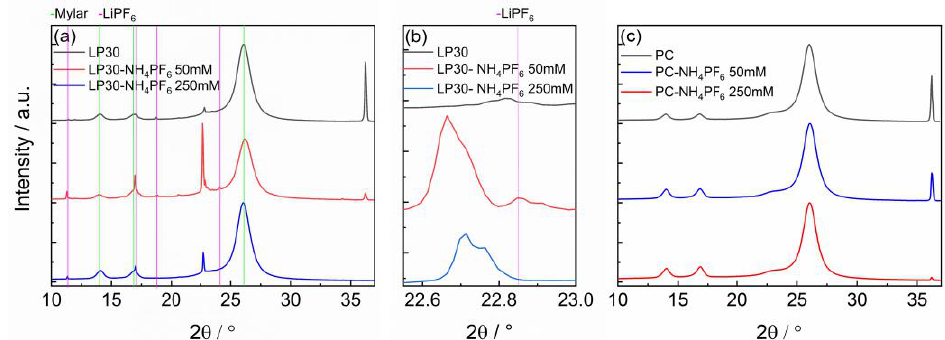
Figure 10. X-ray diffraction patterns of lithium samples after immersion in solution containing 50 and 250 mM NH 4 PF 6 . ( a ) Sample immersed in LP30 with added NH 4 PF 6 , ( b ) enlargement of signal at 22°; ( c ) sample immersed in PC with added NH 4 PF 6 .